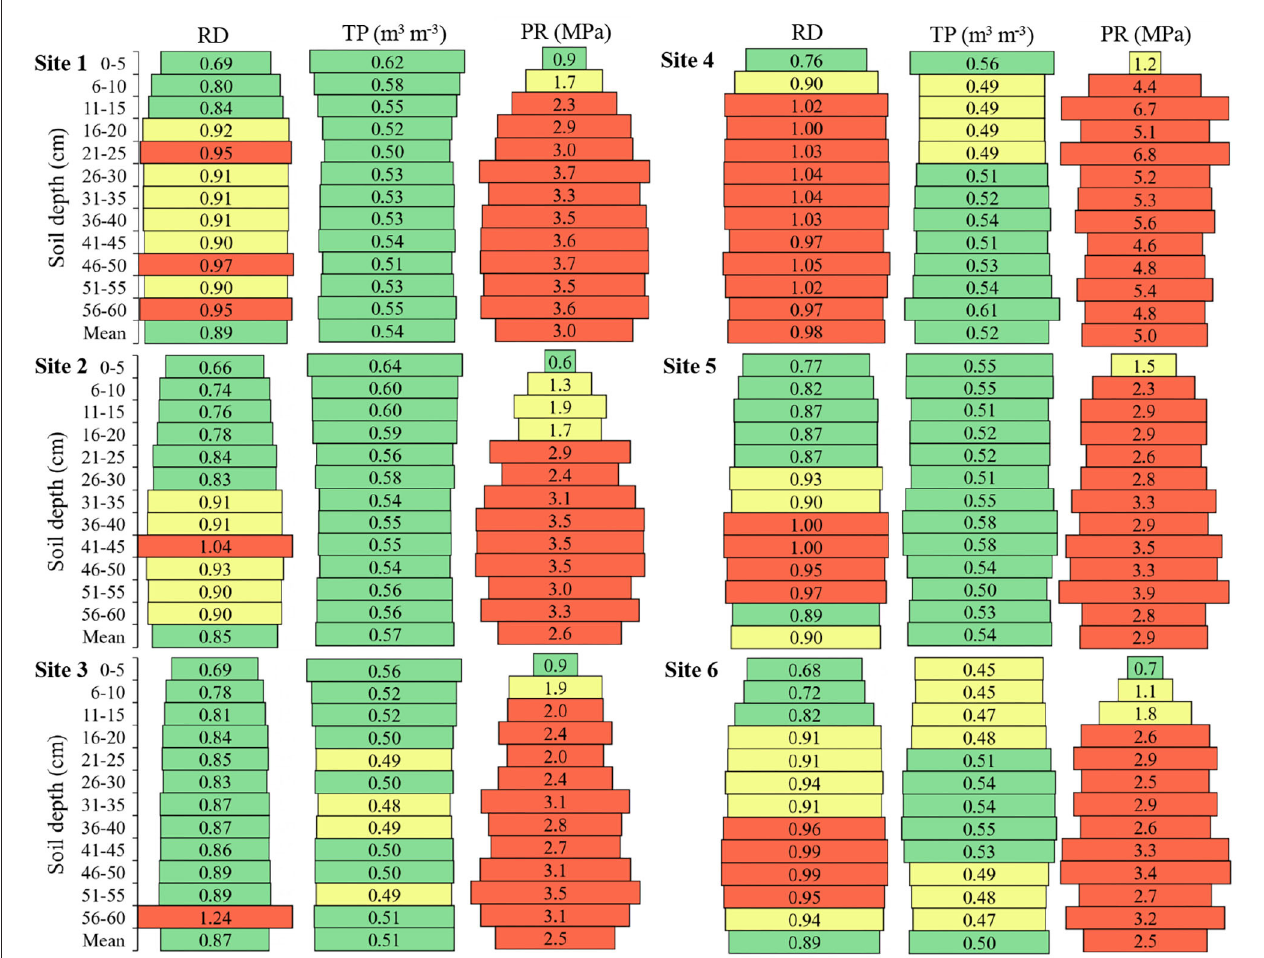
FIGURE 5 | Relative density (RD), total porosity (TP), and soil penetration resistance (PR) in the six sites and at different soil depths. Green color: adequate values (RD < 0.89; TP > 0.50; PR < 1.0); Yellow color: intermediate values (RD 0.90–0.94; TP 0.45–0.5; PR 01.0–1.9); Red color: inadequate values (RD > 0.95; TP < 0.45; PR > 1.9). Adapted from Busscher et al. (2000), Reynolds et al. (2002), and Broch and Klein